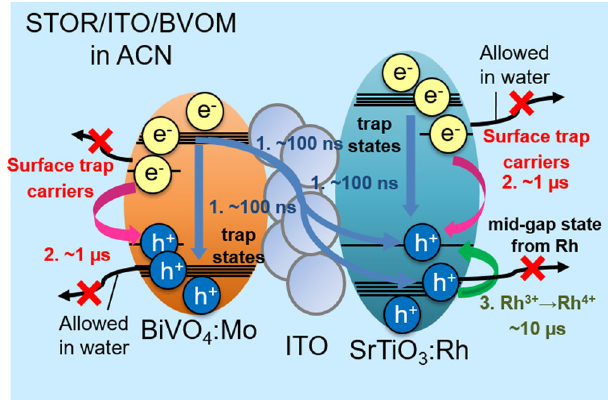
Fig. 3 Schematic drawing of the entire charge dynamics. This scheme corresponds to the charge transfer diagram in SrTiO 3 :Rh/ITO/BiVO 4 :Mo (STOR/ITO/BVOM) in acetonitrile (ACN). Step 1 includes intrinsic recombination inside materials and charge transfer between two materials. Step 2 indicates the decay of surface-trapped charge carriers in ACN, which are utilized for water-splitting reactions with water outside. Step 3 includes the hole trapping to Rh 3 + /4 + state in STOR and the slower recombination. Surface-trapped carriers cannot be transferred to the solution side in ACN, where all processes of charge dynamics are completed in the